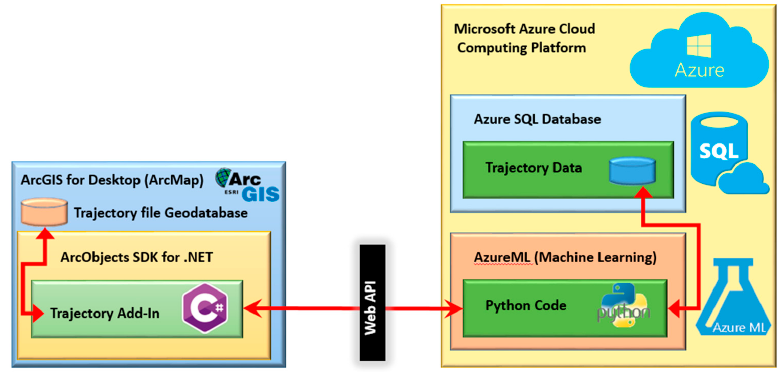
Figure 6. Trajectory analyser dockable window (developed ArcGIS add-in).